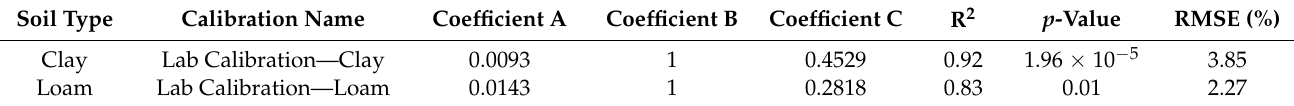
Table 9. Statistical metrics associated with coefficients of various calibration equations (Laboratory calibration—Phase 1). Calibration Soil Type